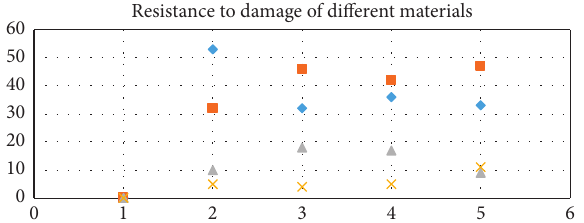
Figure 9: Resistance to damage of different